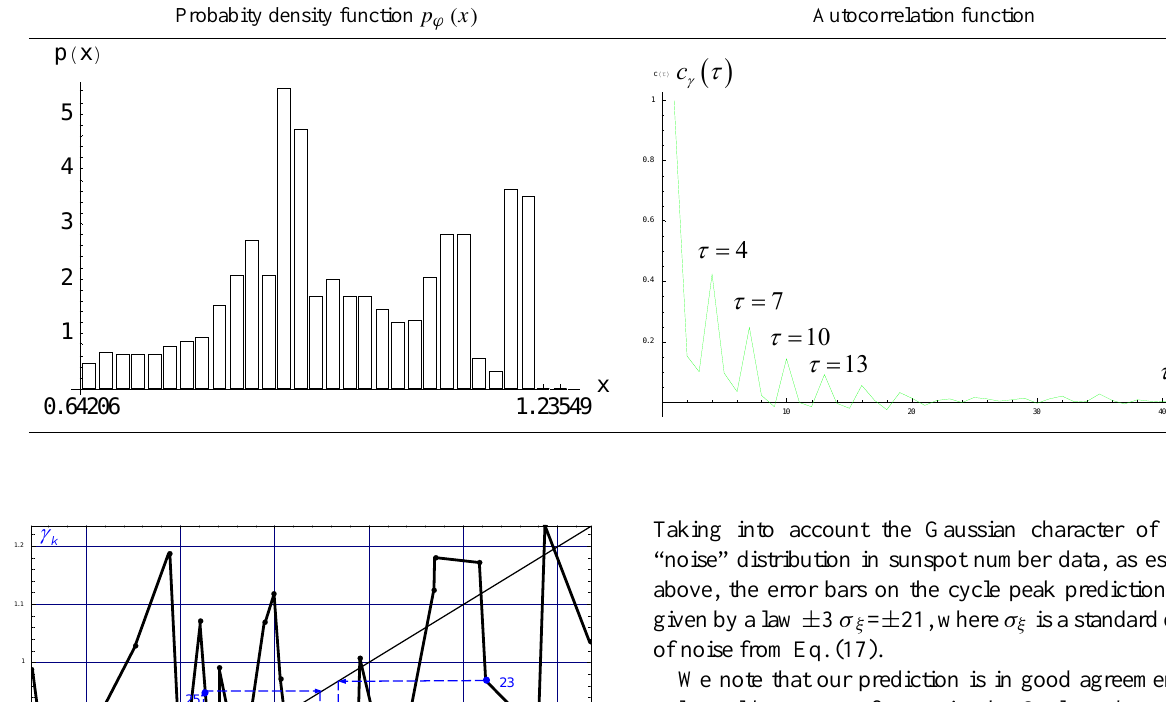
Table 2. Estimates of the PDF and ACF of the parameter γ . Probabity density function p ϕ (x) Autocorrelation function